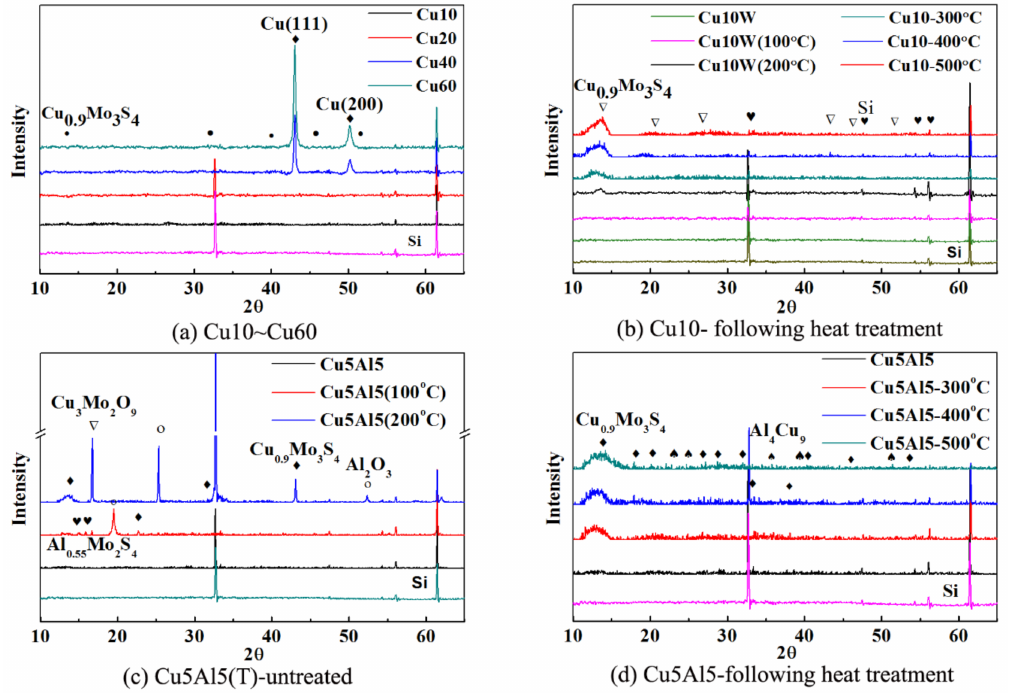
Figure 4. XRD spectrum of Cu/MoS 2 and Cu-Al/MoS 2 composite